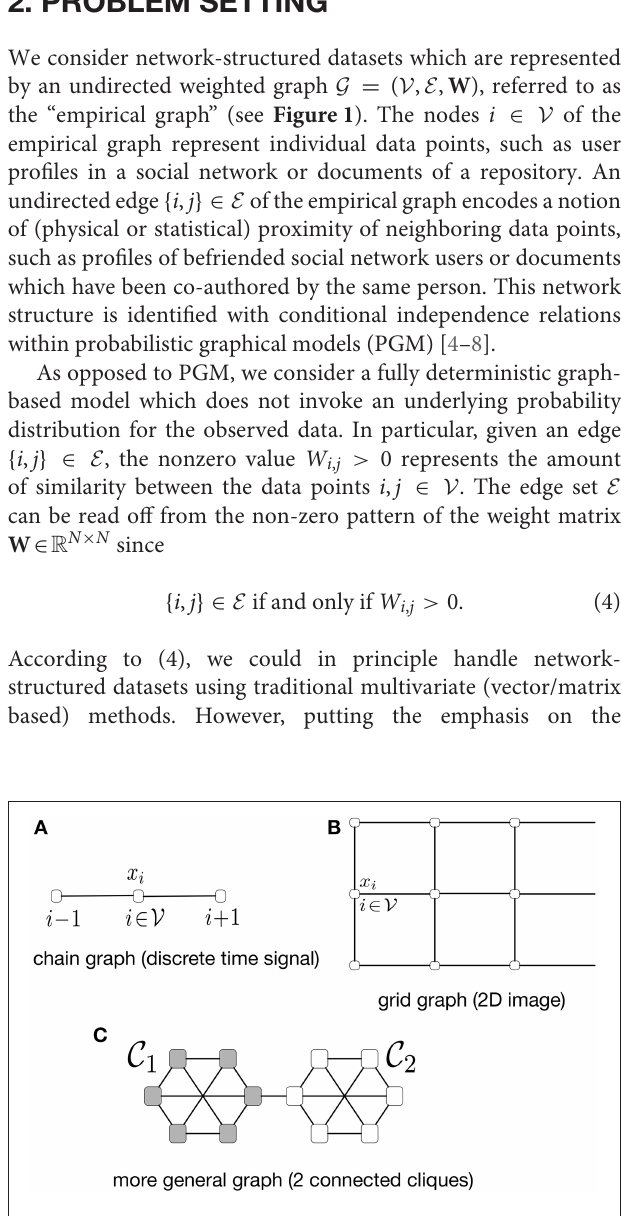
FIGURE 1 | Some examples of network-structured datasets with associated empirical graph being (A) a chain graph (discrete time signals), (B) grid graph (2D-images) and (C) a clustered graph (social